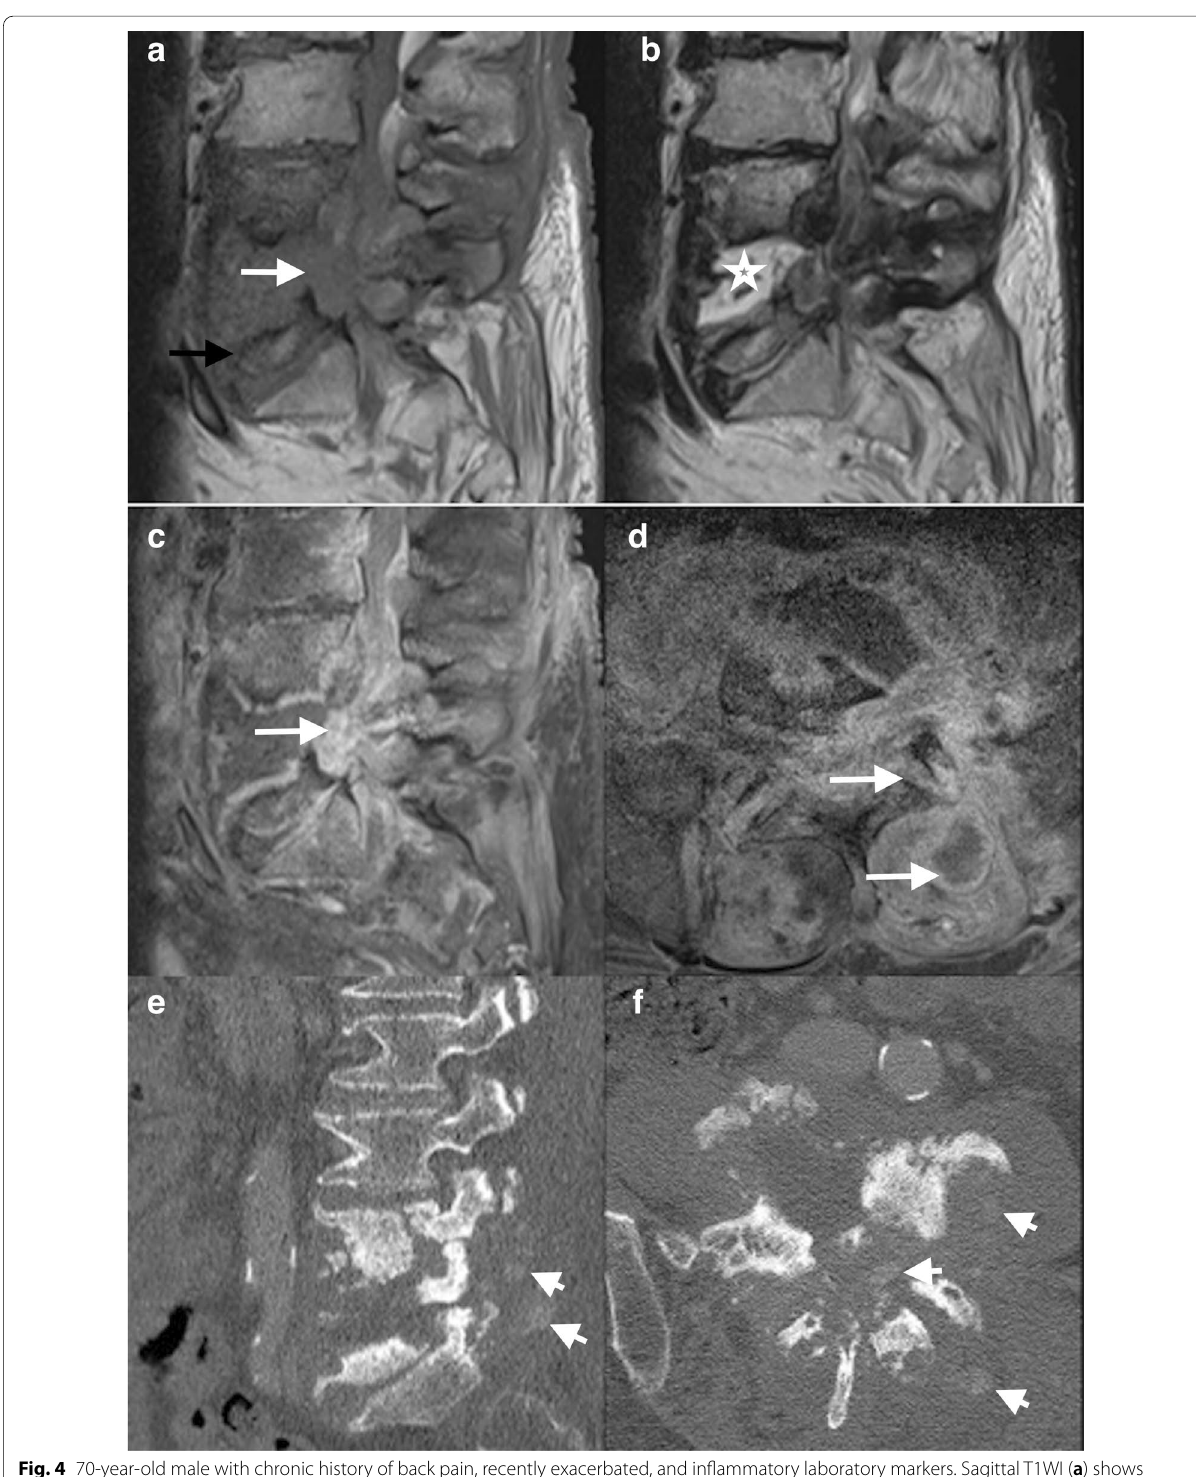
Fig. 4 70-year-old male with chronic history of back pain, recently exacerbated, and inflammatory laboratory markers. Sagittal T1WI ( a ) shows hypointense discal changes in the L4–L5 space and epidural space (arrow). Bony erosion of endplates is also seen (black arrow) at the L5 level ( b , c ). Sagittal T2WI ( b ) shows hyperintense areas in the L4–L5 disc space (star). Contrast-enhanced sagittal and axial T1WI ( c , d ) show enhancement of disc space, epidural space, left facet joint, and paraspinal muscles (arrow). Non-enhancing foci correspond to crystal material (arrow). Axial and sagittal slices of CT ( e , f ) show in L4–L5, disc space erosions, sclerotic vertebral bodies, and confirm gout tophi in muscles (short